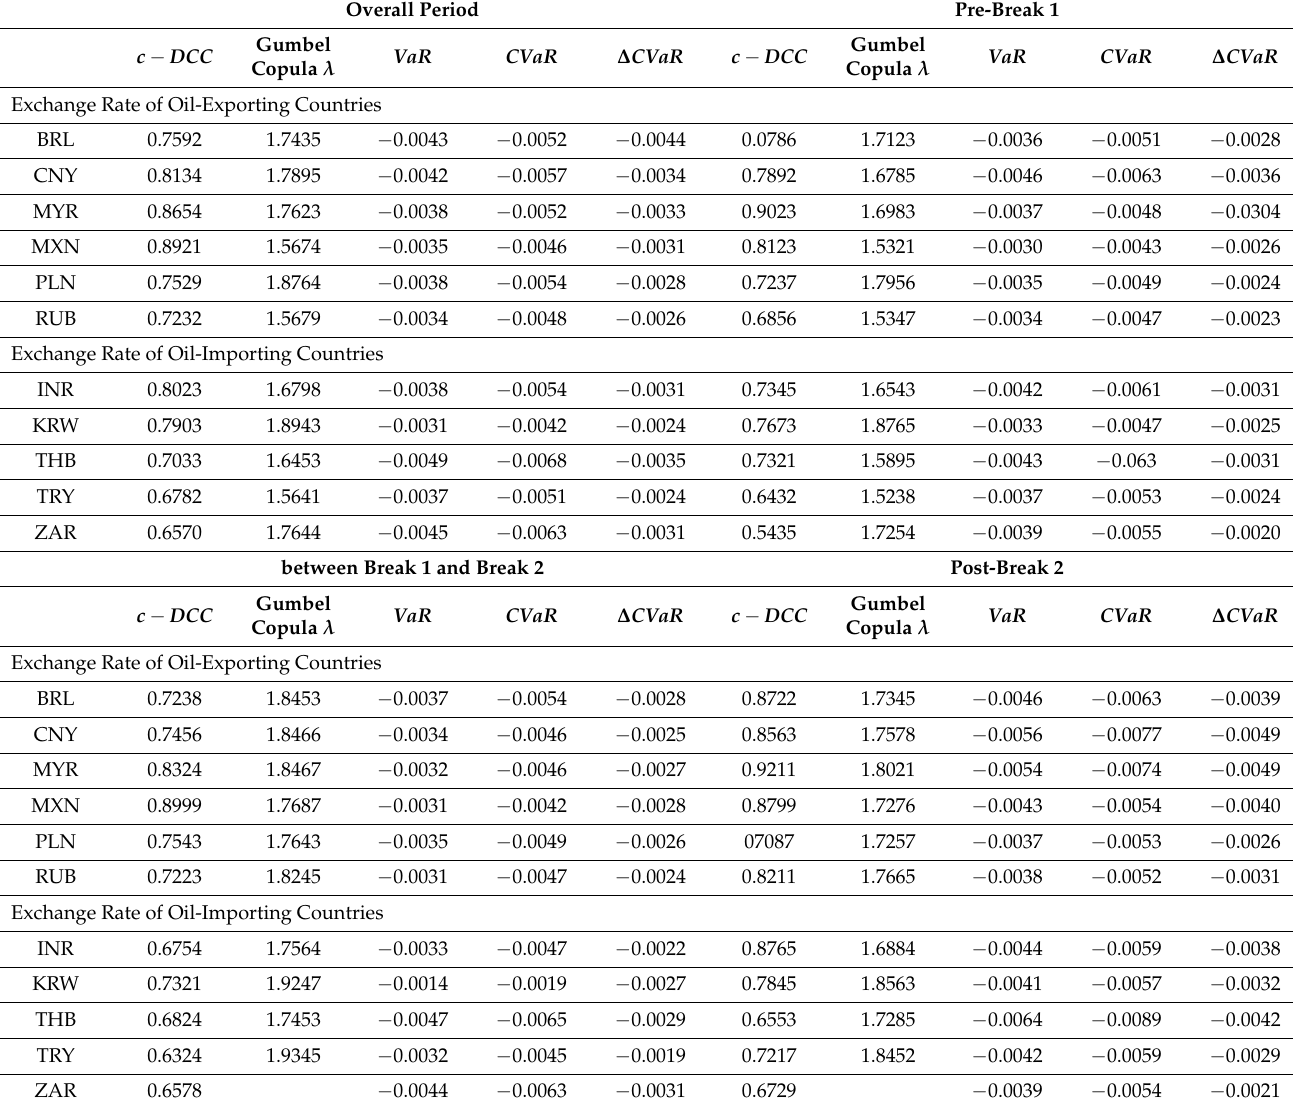
Table 7. VaR , CVaR , and ∆ CVaR averages for